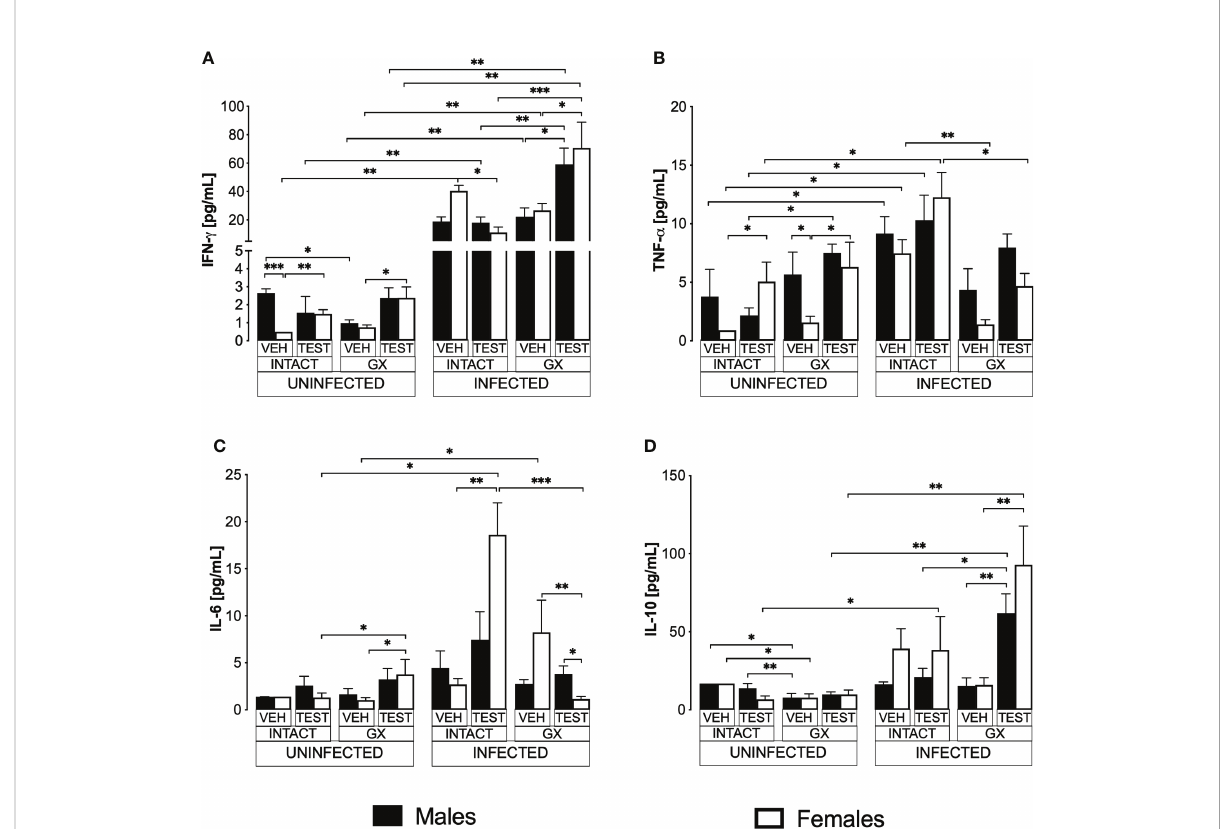
FIGURE 7 Modifying testosterone concentration affected IFN- g , TNF- a , and IL-6 levels in P. berghei ANKA-infected females. We used 8 groups of males and 8 groups of females, 4 groups of each sex were gonadectomised (GX), and the other 4 groups were left intact; four weeks after surgery, two groups of intact and two GX mice of each sex were administered testosterone for 3 weeks, the other two received vehicle for the same time. Finally, one intact (INTACT) and one GX group treated with testosterone of each sex were infected with P. berghei ANKA. The remaining groups were injected with PBS as infection controls. On day 8 post-infection, mice were sacri fi ced, blood was removed, and plasma was used to assess the concentration of IFN- g (A) , TNF- a (B) , IL-6 (C) and IL-10 (D) using fl ow cytometry. Histograms represent the mean ± SEM of each cytokine plasma level in the vehicle-treated (VEH), testosterone-treated (TEST), intact (INTACT), or gonadectomised (GX) groups. Mice infected with P. berghei ANKA (INFECTED) or uninfected (UNINFECTED). Asterisks represent statistical signi fi cance between groups (*) p < 0.05; (**) p < 0.01; (***) p < 0.001; were calculated with a Kruskal-Wallis test with Dunn ’ s post-hoc test. The whole experiment was conducted in duplicate (n =